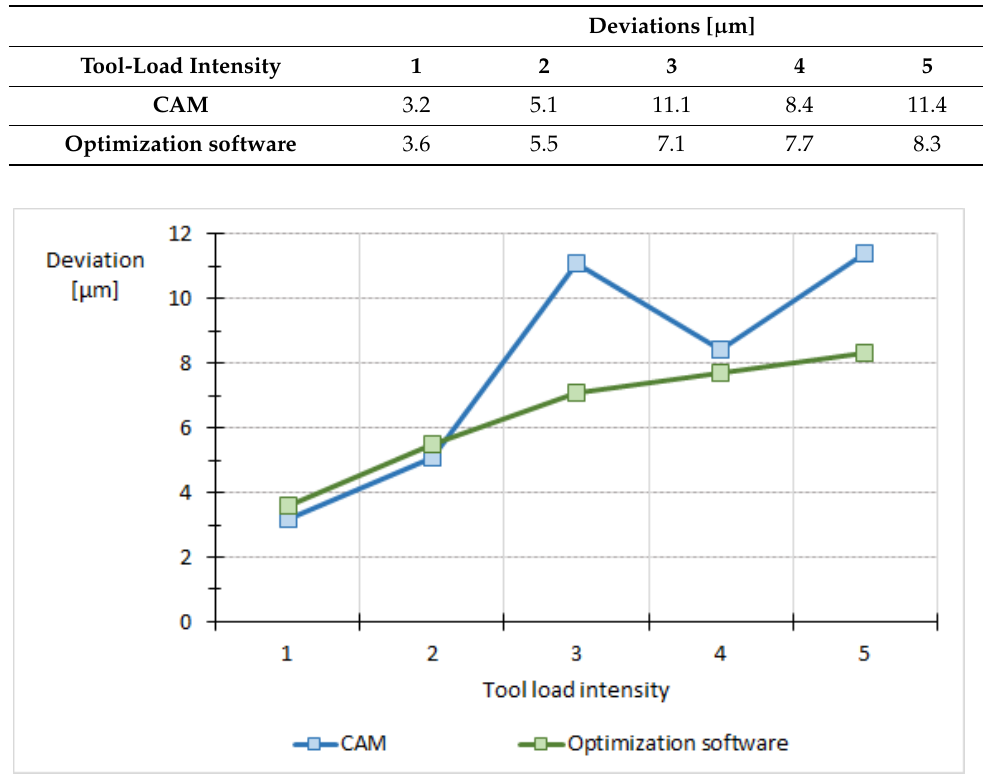
Figure 10. Comparison of maximum deviations at the bottom of the pockets.